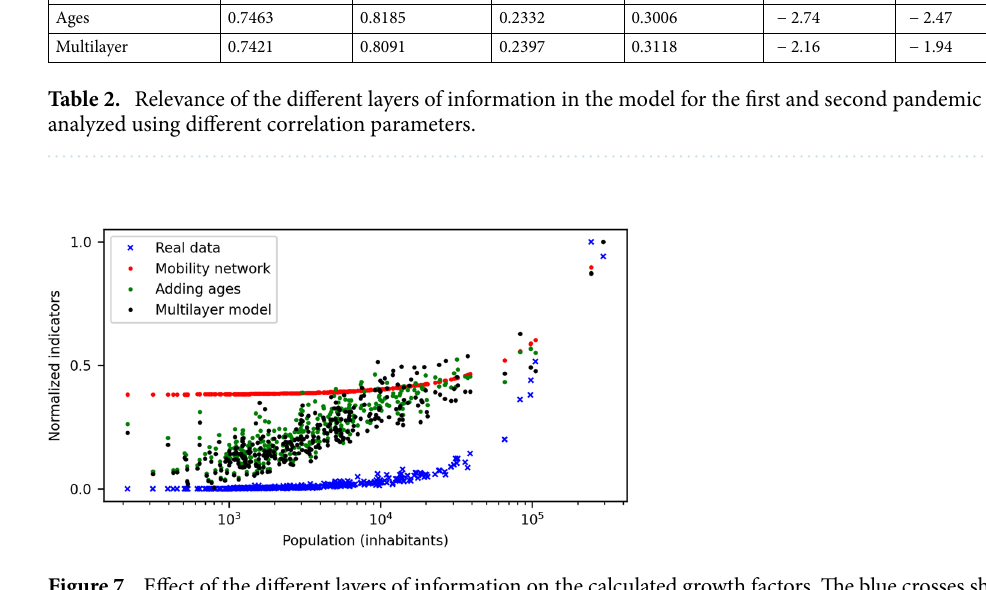
Figure 7. Effect of the different layers of information on the calculated growth factors. The blue crosses show the normalized cumulative incidence data of the second wave. Red dots show the growth factors calculated considering only the mobility information layer in the model. Green dots also include of the age-related economic activity and, finally, the black dots show the growth factors considering all the information layers (including port activity) described in the Method